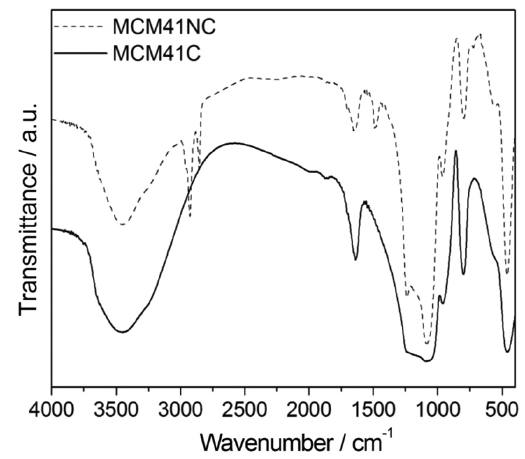
Figure 2. IR spectra for MCM‑41 calcinated (C) and non‑calcinated